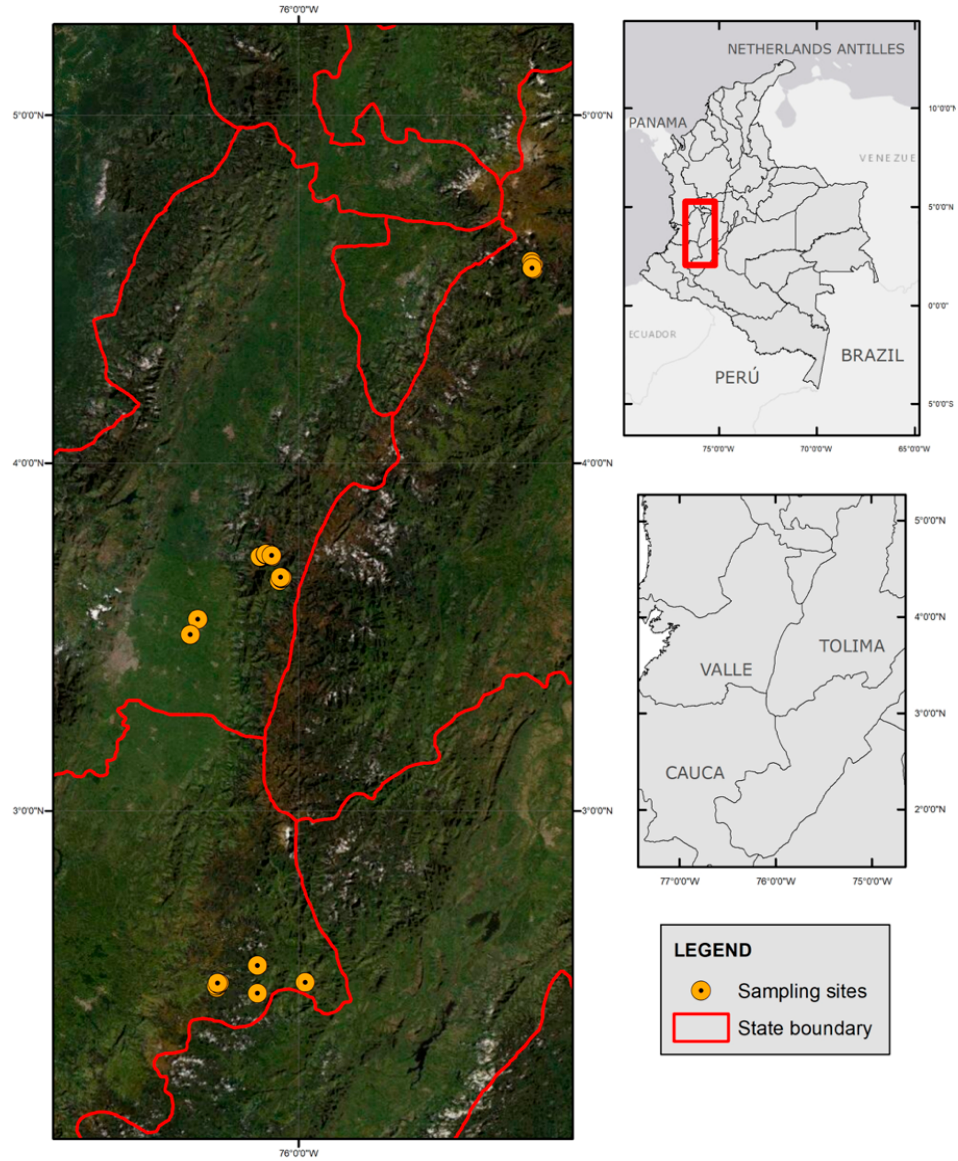
Figure 1. The geographic location. High altitude of Central Andean Mountains. The farms are located at the border of T. ornatus territory, 2600 to 4100 m.a.s.l. Valle del Cauca, Tolima, and Cauca (Colombia). Generated with ArcGIS, version 10.8.1 of SIG laboratory, Universidad